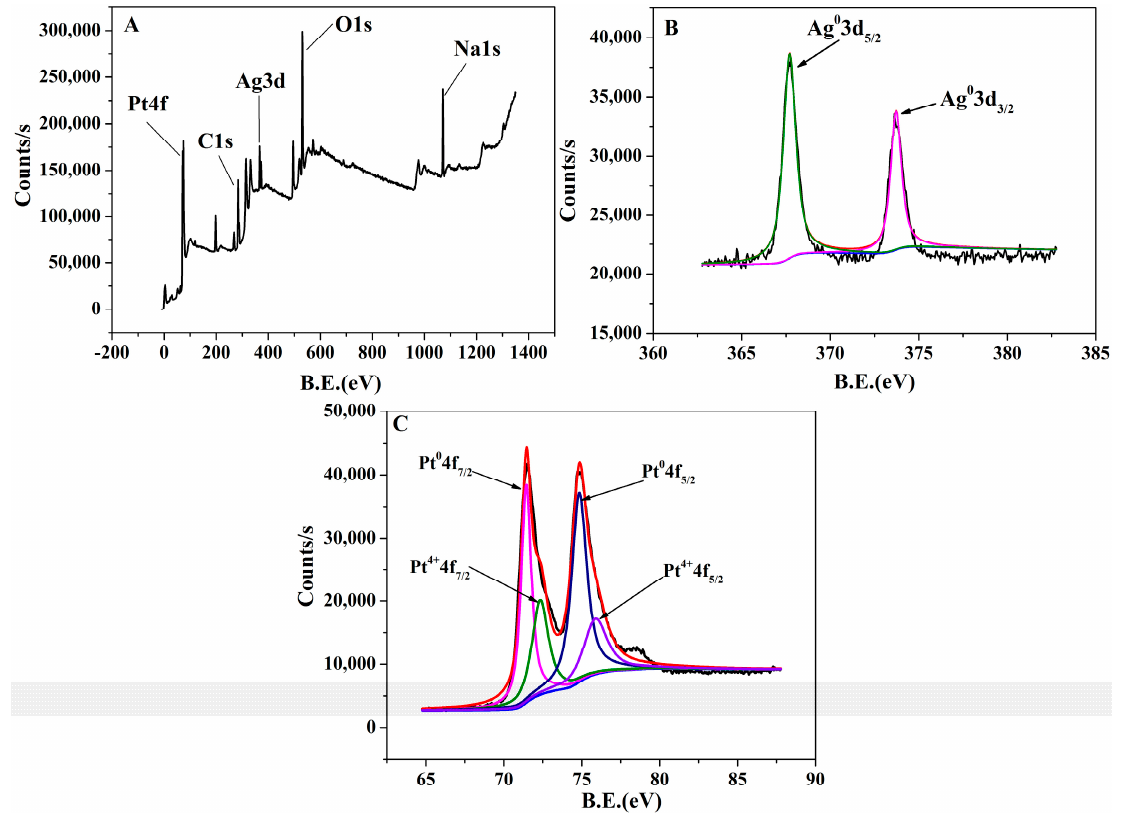
Figure 7. ( A ) The whole XPS spectrum; ( B ) Ag (3d) and ( C ) Pt (4f) XPS spectra of citrate-modified PtNPs after being treated with Ag +